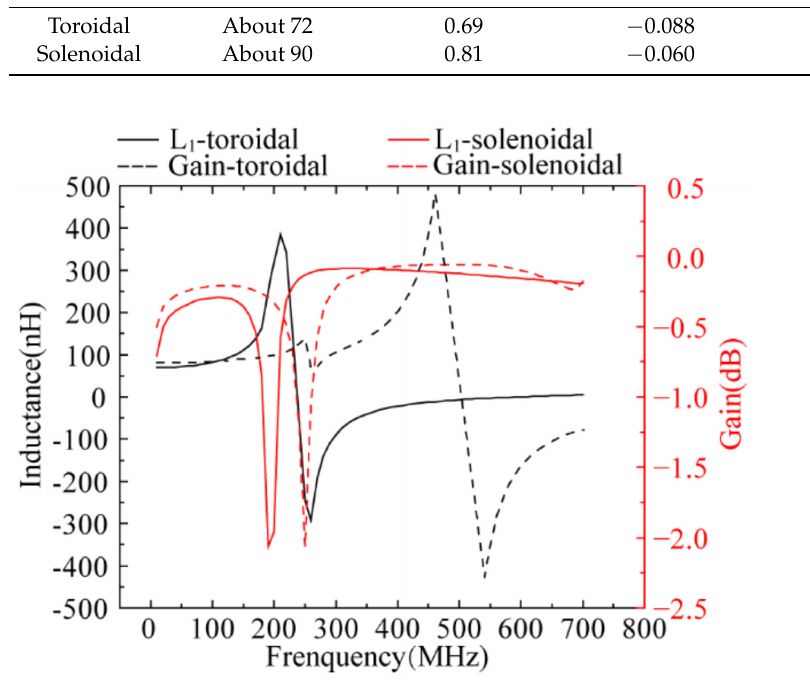
Figure 11. Simulation results of the two